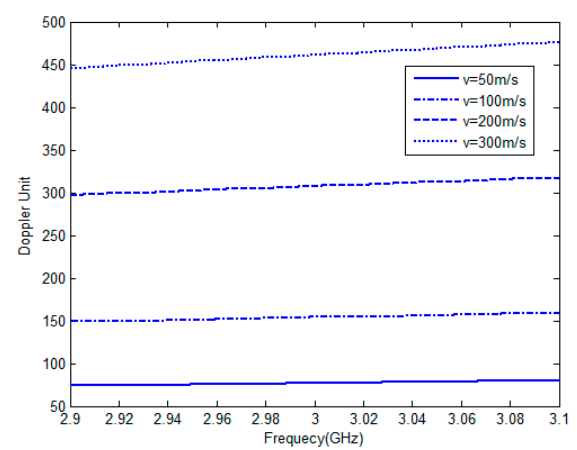
Figure 1. Doppler distribution in fast-time frequency domain.